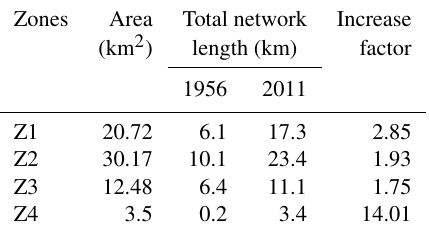
Table 6. For the four subwatersheds, area, total drainage network length in 1956 and 2011 and the factor of increase between these two periods are